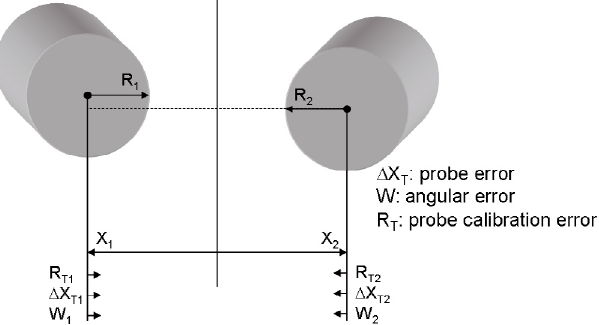
Fig. 5. Derivation of the measurement equation for the radius- distance